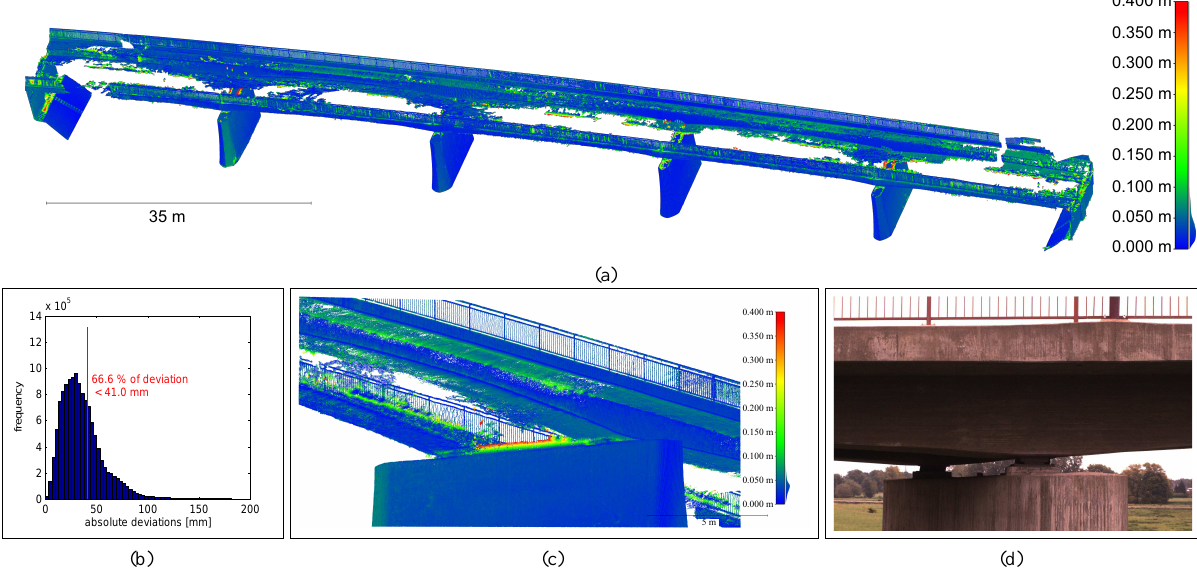
Figure 9: (a) Color-coded absolute distances between SfM and TLS point clouds obtained by CloudCompare. (b) Histogram of absolute distances. (c) Section of the SfM point cloud showing good points (blue), inaccurate points (red) and holes in the point cloud. (d) Images of the SfM network can be used for visual inspection for instance to detect and localize damage on